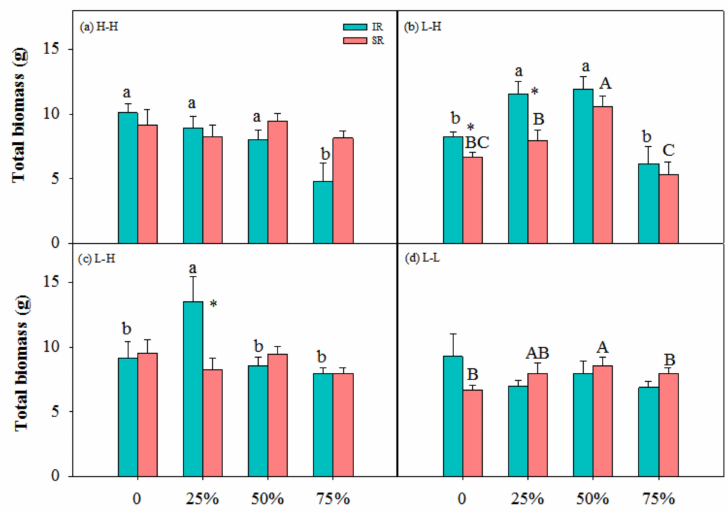
Figure 1. Total biomass of ramets with intact rhizome (IR) and severed rhizome (SR) with increasing clipping levels in di ff erent nutrient treatments. ( a ) H-L, ( b ) L-H, ( c ) H-H and ( d ) L-L indicate high-low, low-high, high-high and low-low nutrient treatments, respectively. The error bars represent standard errors (SE), and bars with di ff erent lower-case and upper-case letters indicate significant di ff erence among clipping levels for ramets with intact and severed rhizome, respectively ( p < 0.05). *—significant di ff erence between ramets with IR vs. SR at the same clipping level.